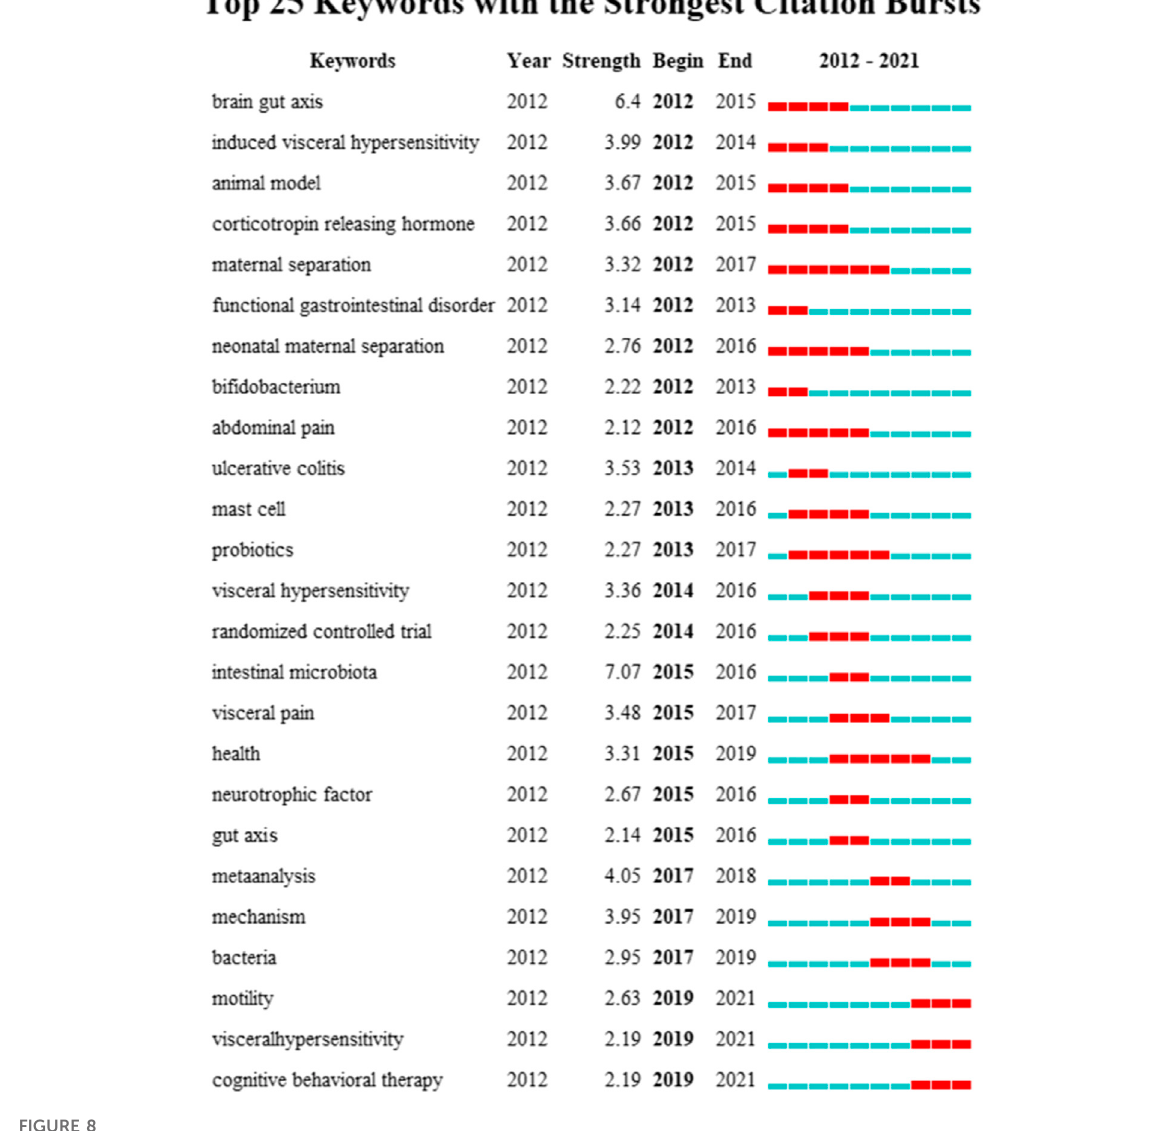
FIGURE 8 Top 25 keywords with the strongest citation